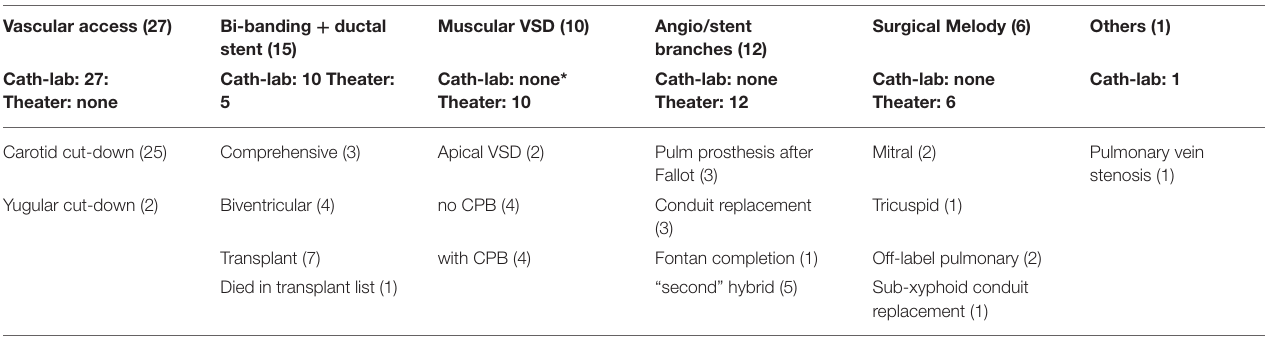
TABLE 1 | Distribution of hybrid procedures in